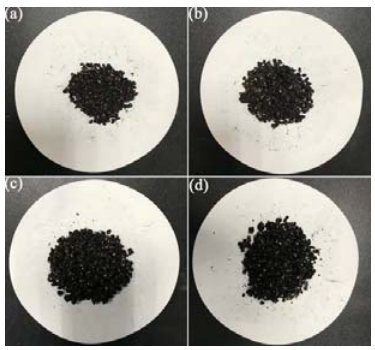
Figure 1. Photographs of polyethylene glycol (PEG)-carbon nanotubes (CNTs) with expanded vermiculite (EVM) form-stable composite phase change materials (PCE-CPCMs) with good form stability: ( a ) PCE1.59, ( b ) PCE3.30, ( c ) PCE5.20, and ( d ) PCE7.09.